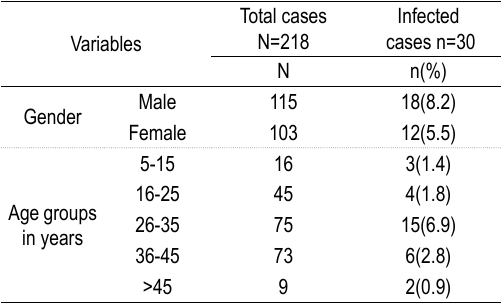
Table 1. Demographical distribution of Blastocystis homi-